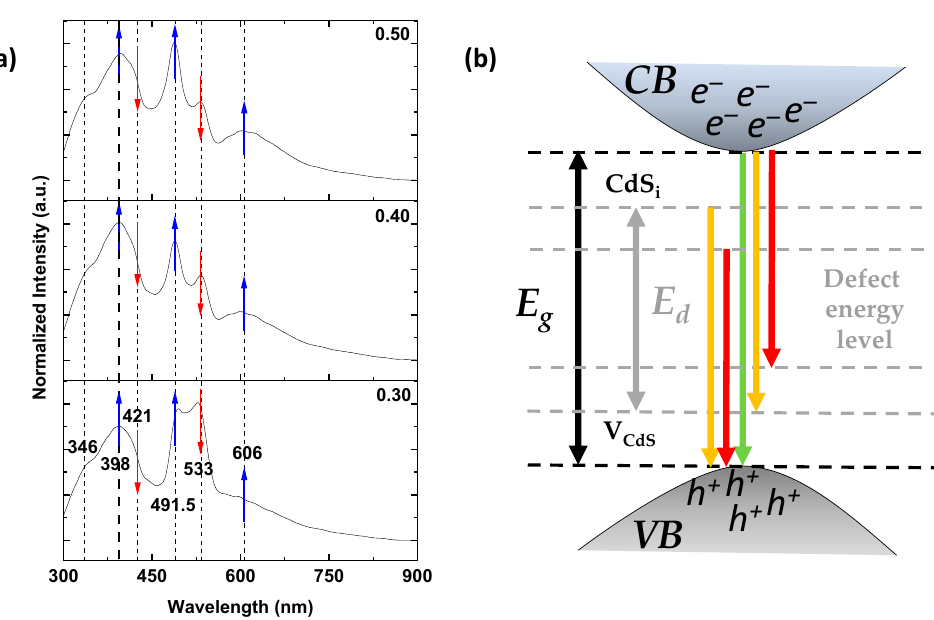
Figure 5. ( a ) Normalized photoluminescence spectra of the thin films showing intensity changes due to Al content (blue and red arrows). ( b ) Schematic energy level diagram showing some of the principal defect levels in CdS:Al thin fi lms.